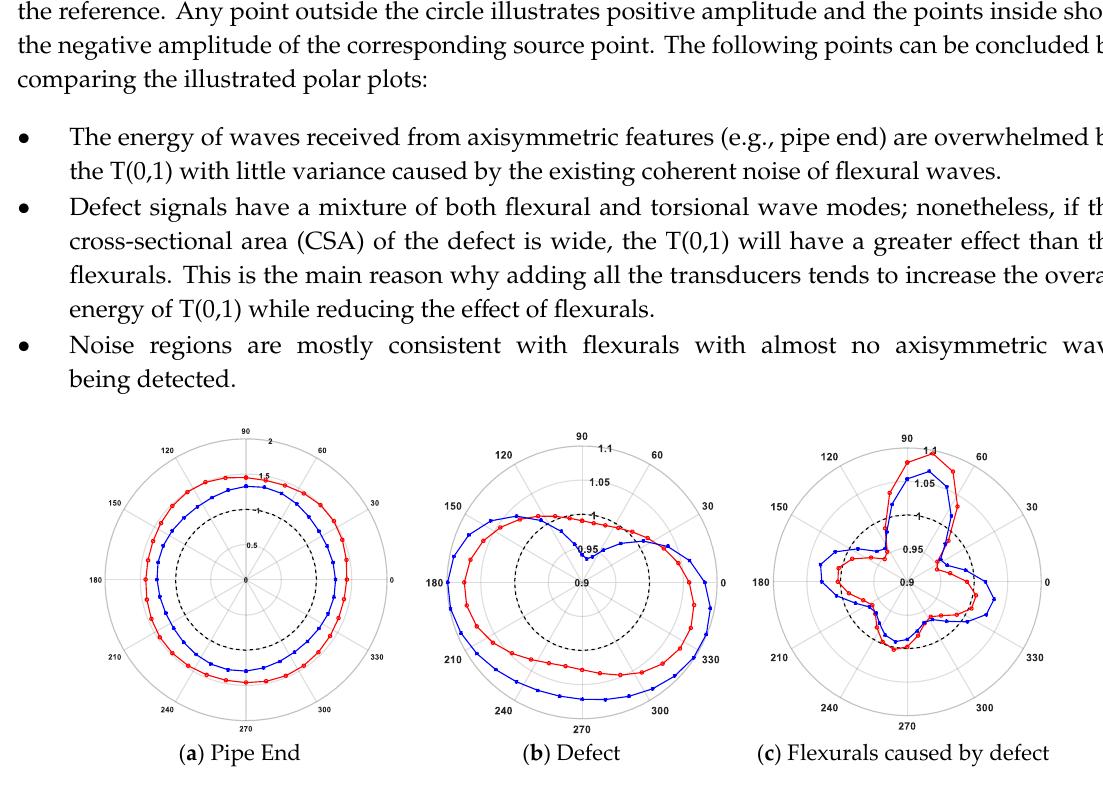
Figure 1. Example of received FEM signals from the array from different sections of a pipe [31]. Furthermore, guided waves exhibit dispersive propagation. Dispersion causes the energy of a signal to spread out in space and time as it propagates [32]. Figure 2a shows an example of a dispersion curve calculated from an 8-inch schedule 40 steel pipe using RAPID software [33]. Wilcox